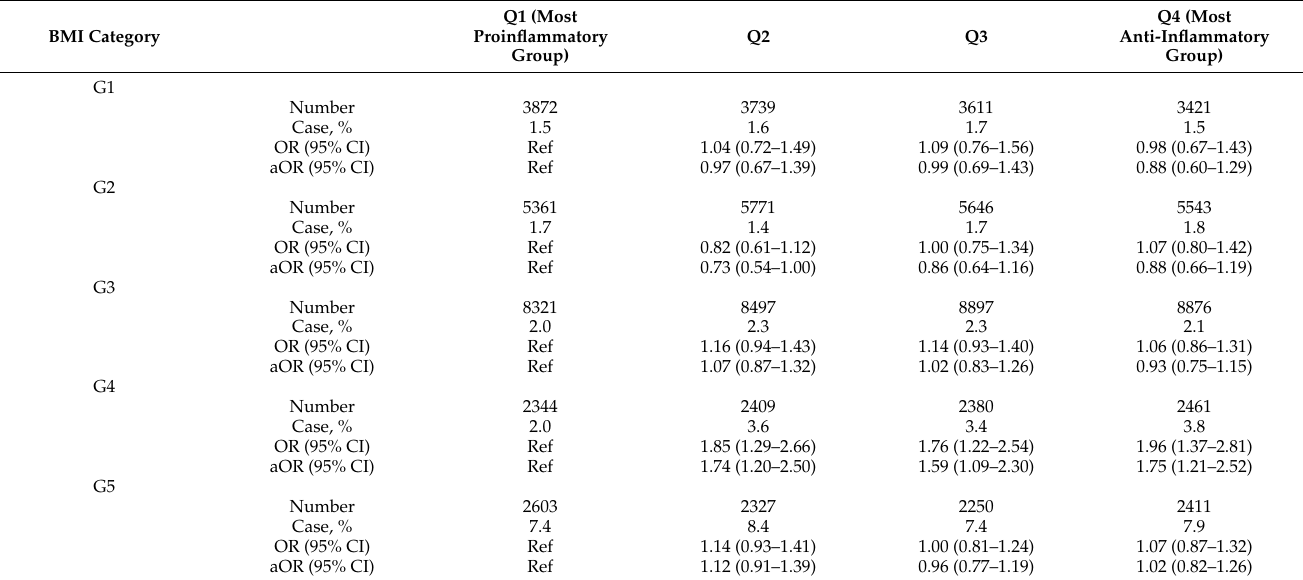
Table 3. Relationship between the dietary inflammatory index DII and the risk for gestational diabetes mellitus (GDM).